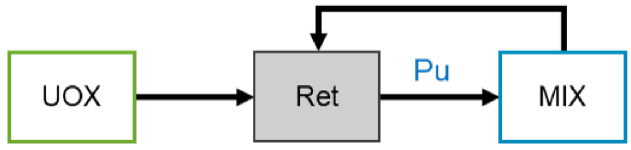
Fig. 7. Fuel cycle of a UOX - MIX fleet.